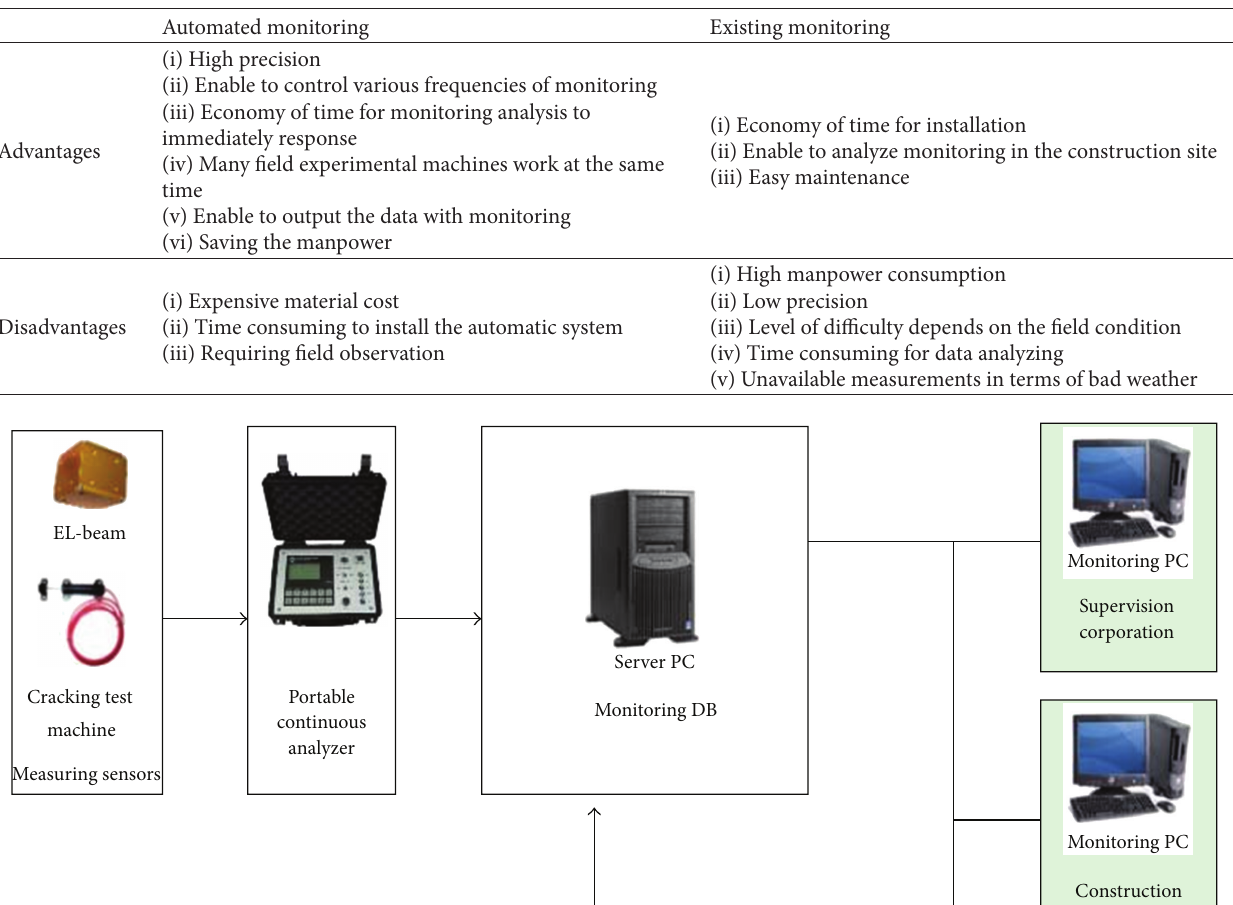
Table 1: Comparison between existing monitoring and automated monitoring system.